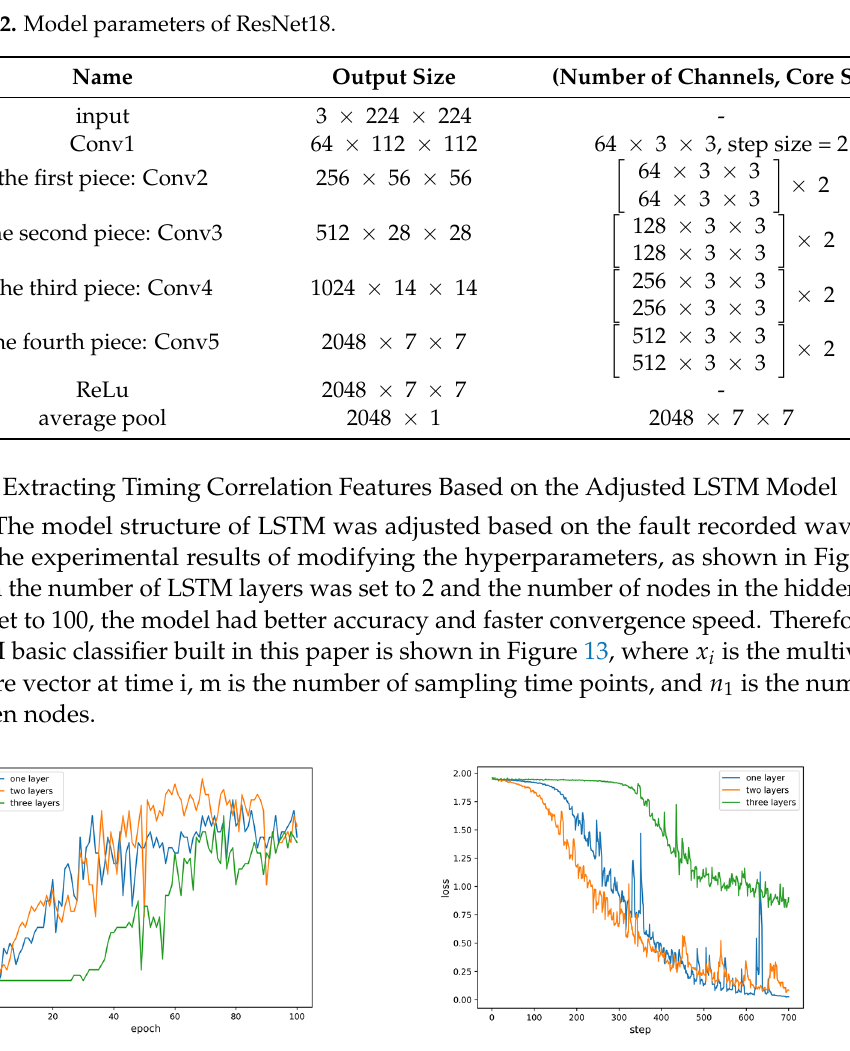
Figure 12. Comparison results of accuracy and loss function when LSTM sets different layers.